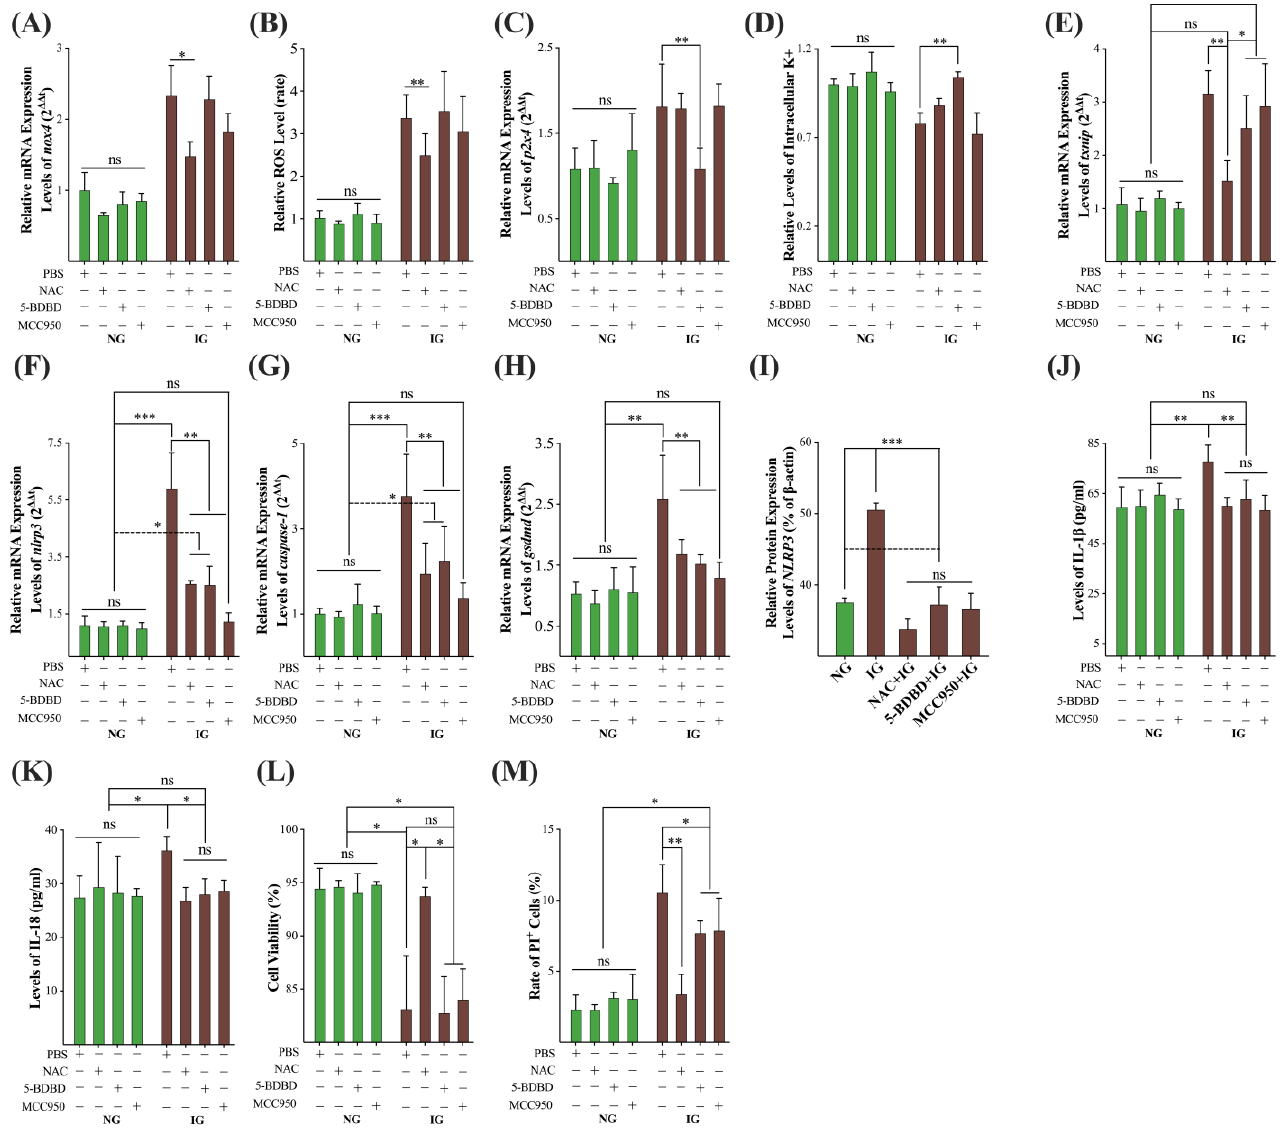
Figure 6. Inhibitors blocked the IG treatment-induced activation of the nlrp3 / caspase-1 / gsdmd pyroptosis pathway. ( A , B ) The effects of inhibitors on the mRNA expression levels of the nox4 gene and intracellular ROS levels; ( C , D ) the effects of inhibitors on the mRNA expression levels of the p2x4 gene and intracellular K + levels; ( E – H ) the impact of inhibitors on the mRNA expression levels of txnip , nlrp3 , caspase-1 , and gsdmd genes; ( I) the effects of inhibitors on the expression levels of the NLRP3 protein; ( J – M ) the impact of inhibitors on the IL- 1β , IL-18, cell viability, and rate of PI + cells, respectively. All experiments were repeated 3 times, and the data were presented using mean ± SD. ANVOA, *, p < 0.05; **, p < 0.01; ***, p < 0.001; ns, non-significant.